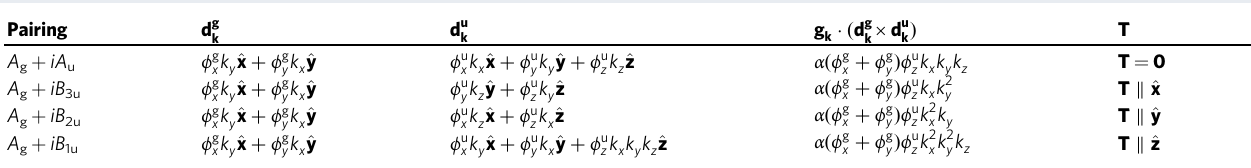
Table 1 Symmetry analysis of Bogoliubov spectrum asymmetry for UTe 2 .